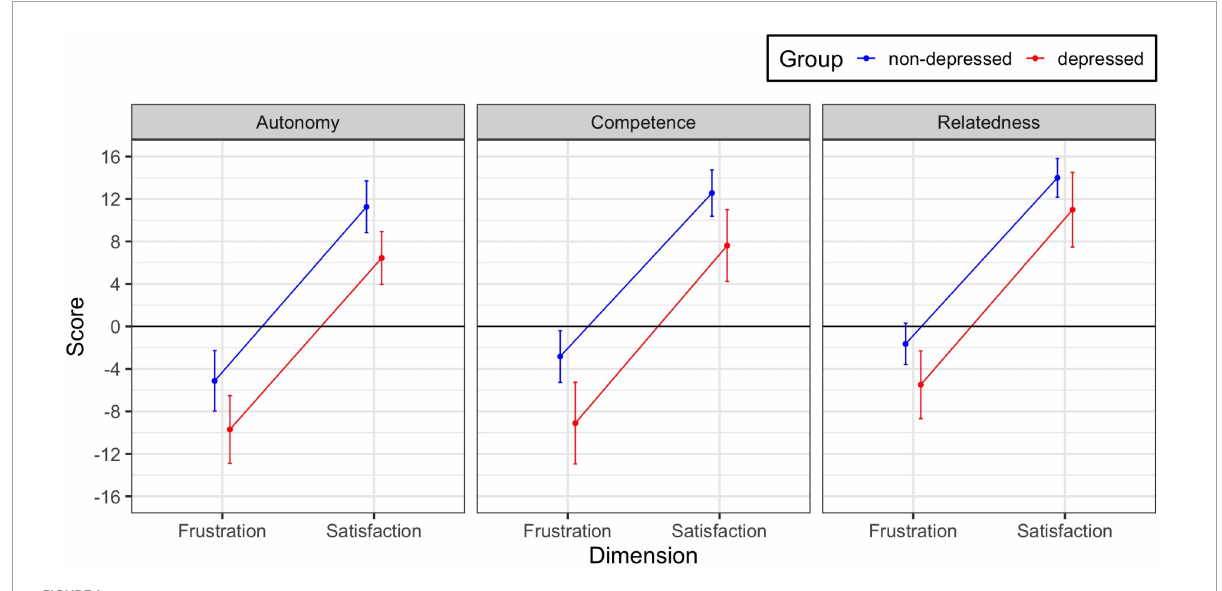
FIGURE1 Observed group × dimension interactions for the three need domains. The interactions are significant for needs of competence and relatedness. Error bars are 95% confidence